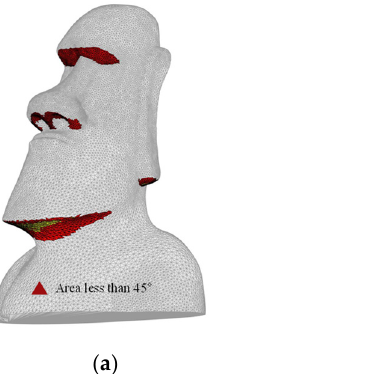
Figure 15. Characteristics of the example model: ( a ) Overhang region, ( b ) Optimized deposition speed map.